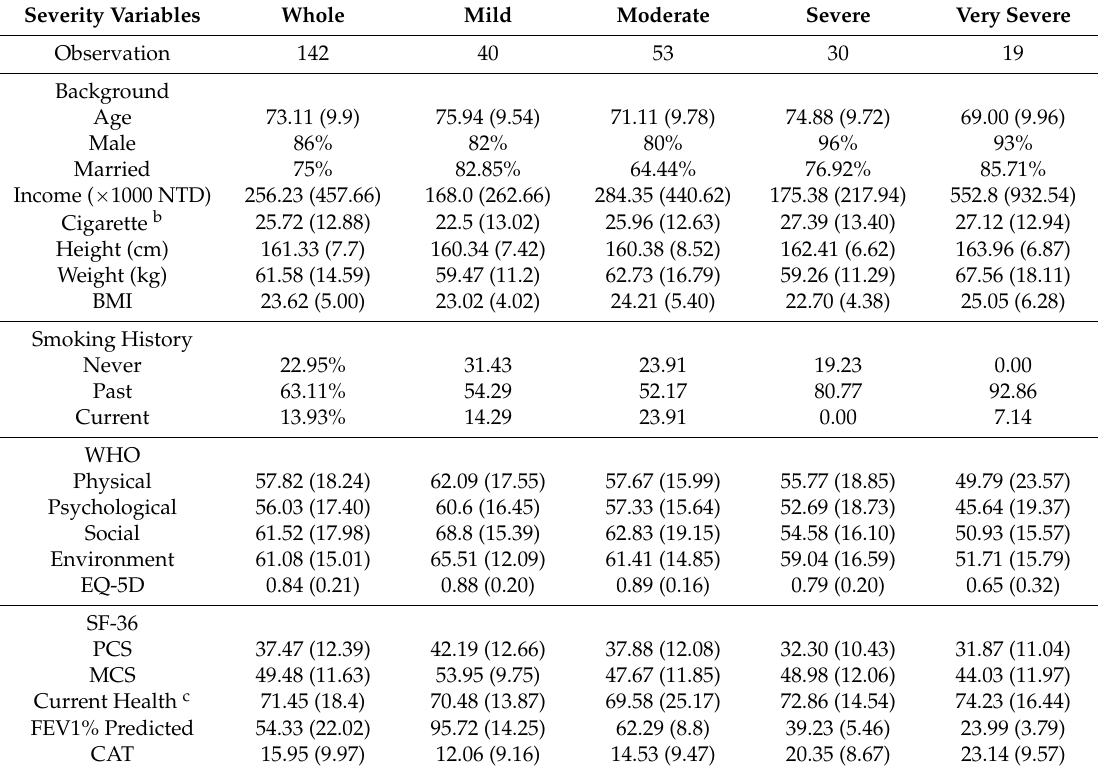
Table 1. Statistical summary of patient backgrounds a